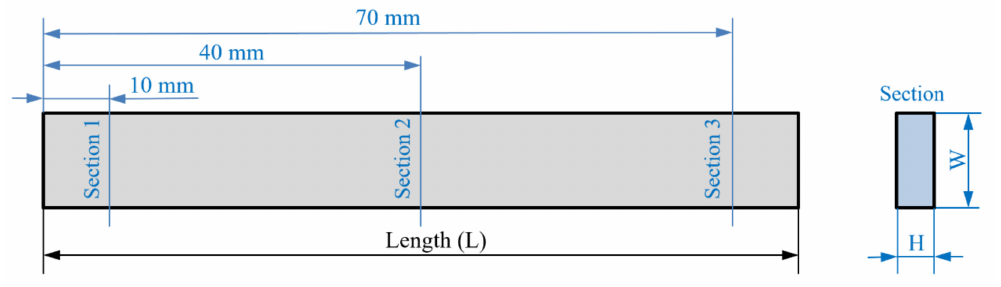
Figure 6. Measured sections in each specimen.